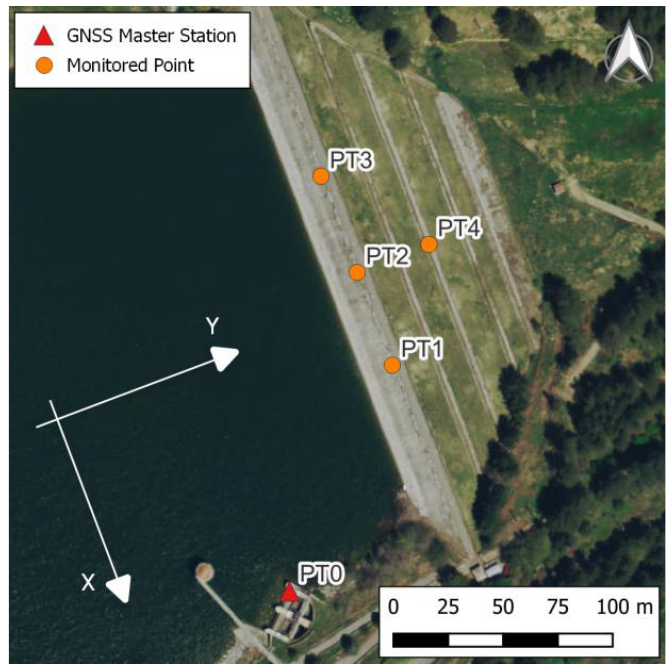
Figure 1. Map of the monitored points on the dam, showing the orientation of the axes of the local reference system.